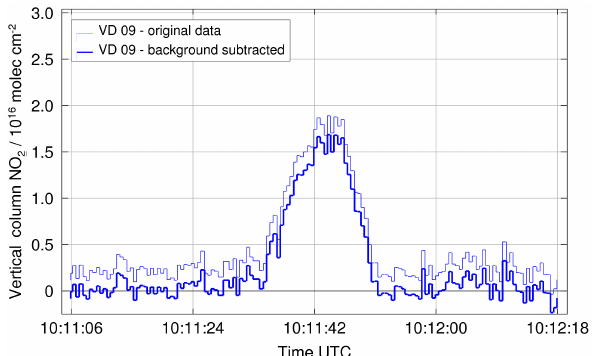
Figure 17. Cross section of NO 2 vertical columns through the ex- haust plume at around 10:12 UTC and a distance of around 6km from the power plant used for the emission flux calculation. The cross section is taken from the ninth viewing direction of the LOS09